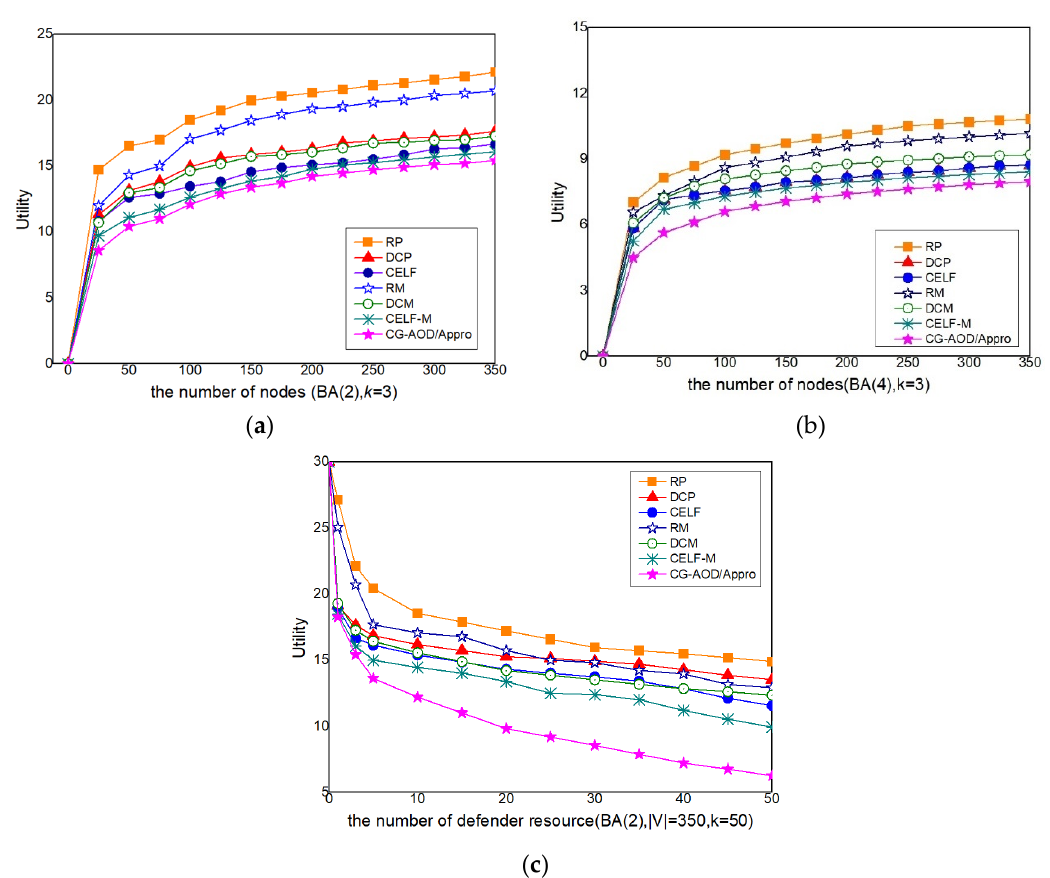
Figure 7. The performance of CG-AOD/Appro on synthetic networks against attackers ( a – c